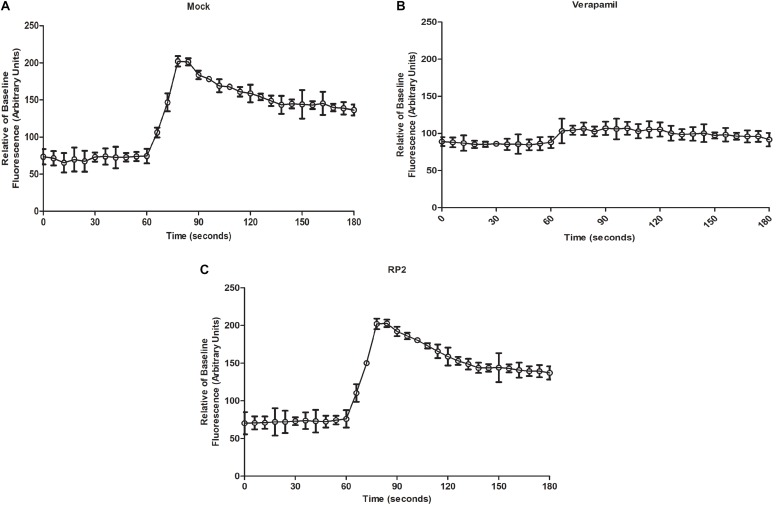
Mammalian calcium channel inhibition assays (A) Cytoplasmic Ca2+ measures of mock-treated cells with carbachol added at 60 s (B,C). Same as panel A except that cells were treated with verapamil (50 μg/mL) (C) or RP2 (32 μg/mL), at 45 s pre-carbachol treatment. The results presented correspond to the mean of three independent readings ± SD.